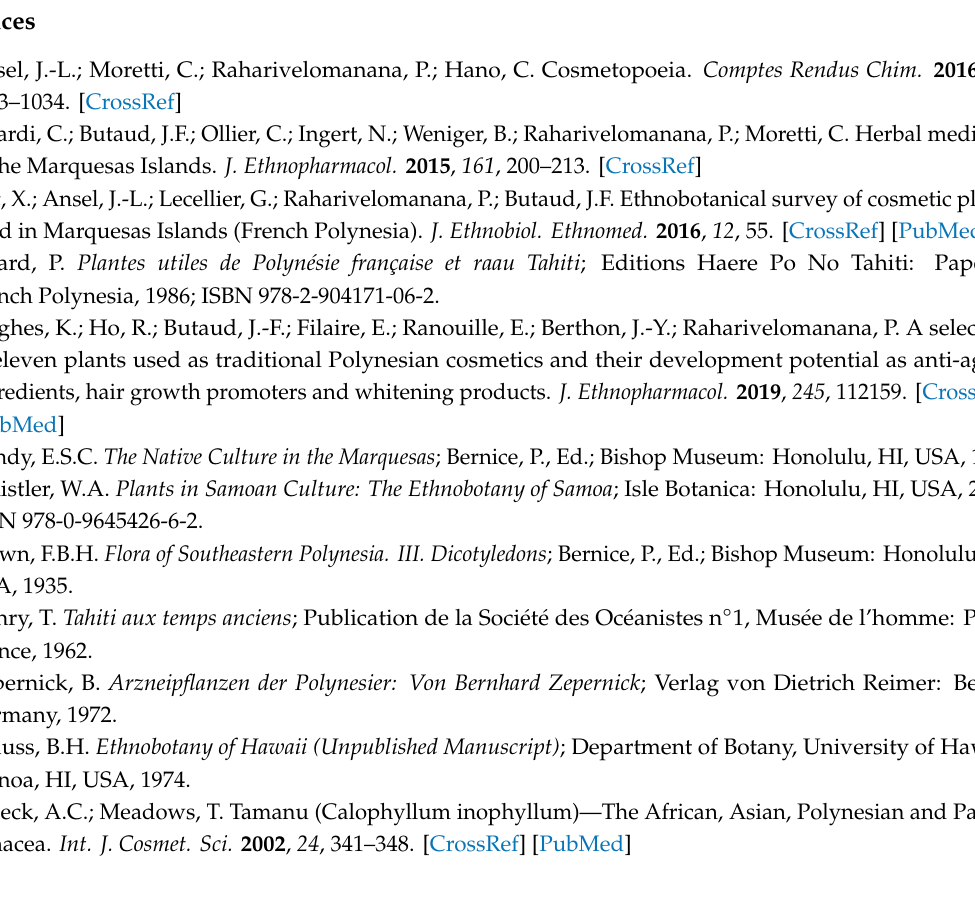
Supplementary Materials: The following are available online. Table S1: Detailed MS 2 data, Table S2: DPC proliferation values-SEM- p -values, Table S3: RT-qPCR Gene expression